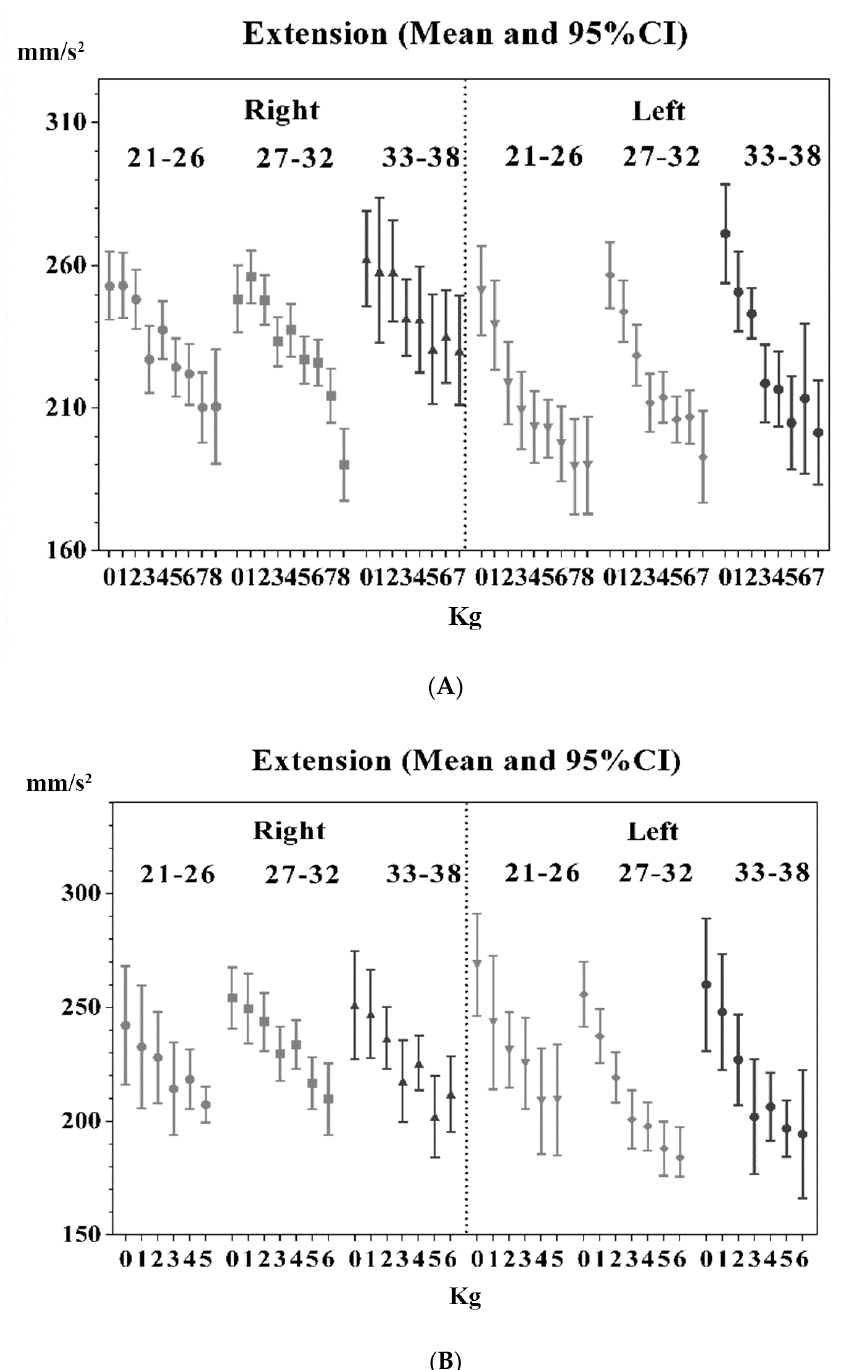
Figure 4 ( A ): Speed–weight relationship in movement extension in males . ( B ): Speed–weight rela- Figure 4. ( A ): Speed–weight relationship in movement extension in males. ( B ): Speed–weight tionship in the extension movement in women relationship in the extension movement in